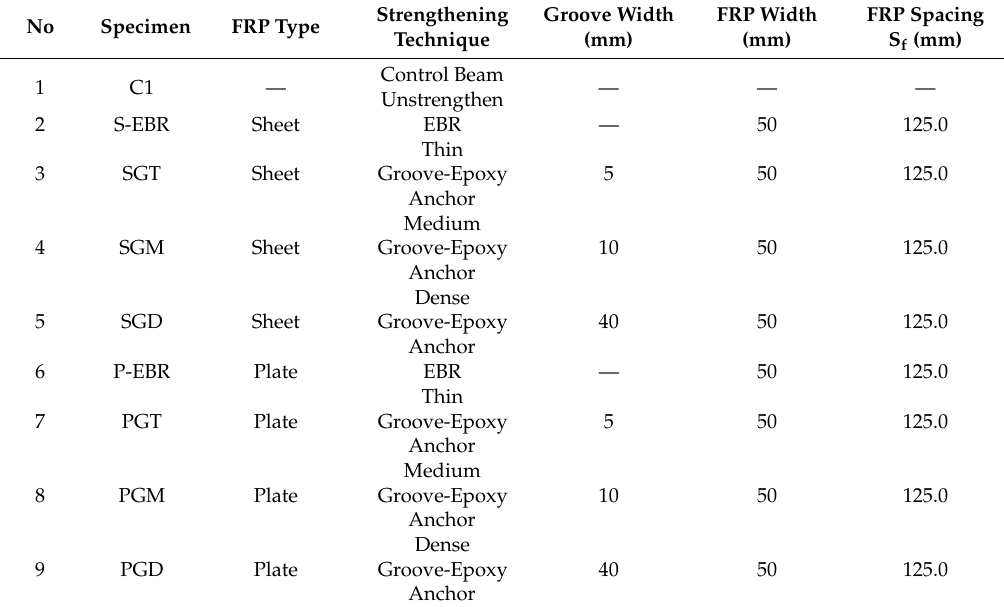
Table 1. Details of the test matrix.